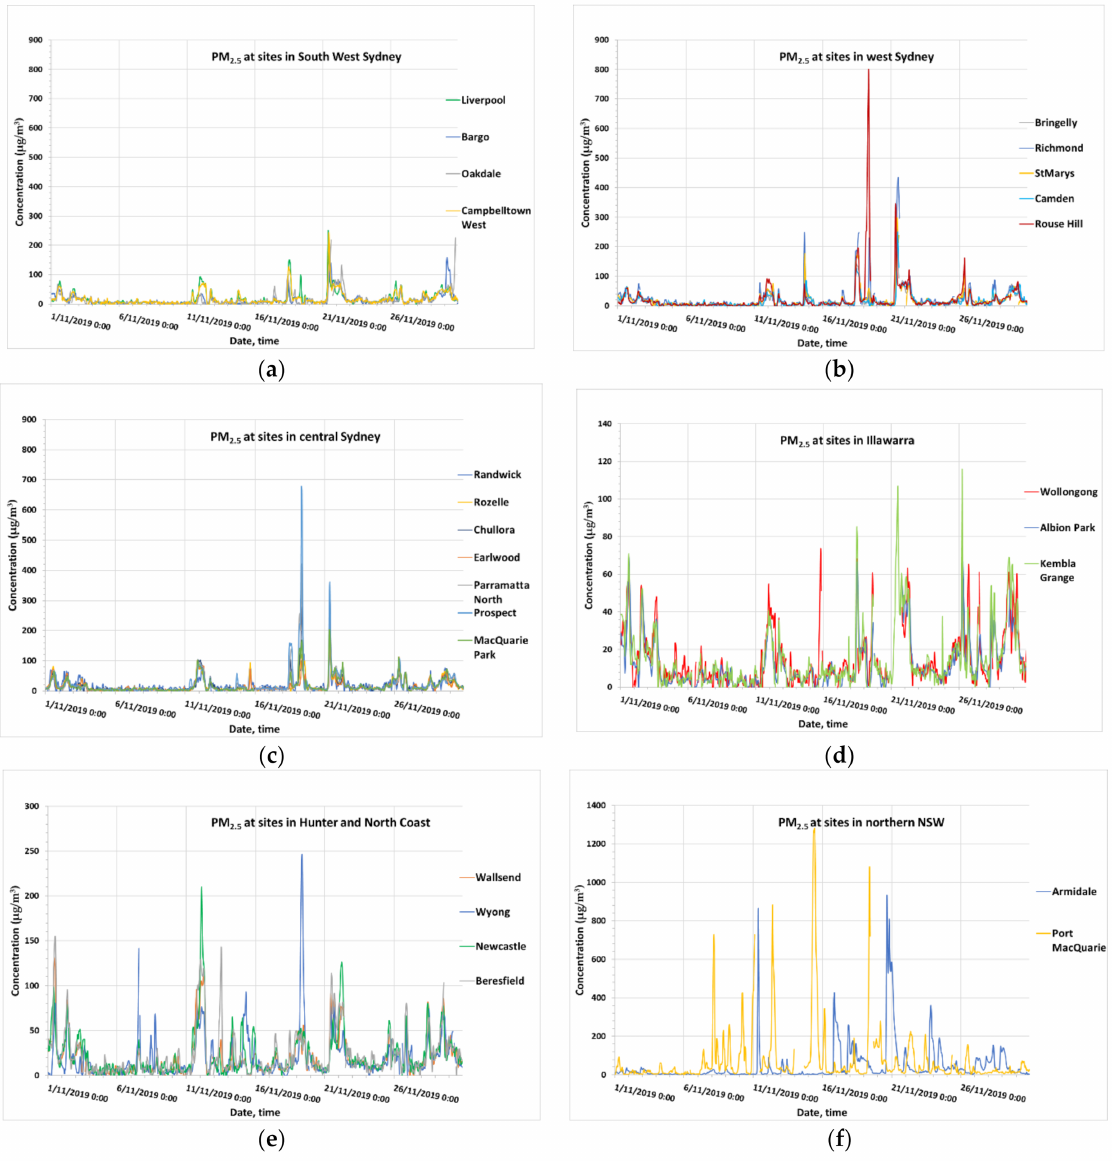
Figure 7. PM 2.5 concentration at monitoring sites in South West Sydney ( a ), west Sydney ( b ), central Sydney ( c ), Illawarra ( d ), Hunter ( e ) and northern NSW ( f ) from 1 November 2019 to 30 November 2019. From early December, the fires caused an elevated concentration of PM 2.5 up to 273.7 µ g/m 3 (6 December 2019, 08:00) as measured at Port Macquarie. High PM 2.5 concen- trations from 200 µ g/m 3 up to above 400 µ g/m 3 were measured at a number of stations in Sydney (Bringelly, Camden, Liverpool, Oakdale, Campbelltown West, Rozelle, Randwick, Parramatta North, Chullora, Earlwood, Macquarie Park and Prospect) and in the Lower Hunter–Central Coast region (Wallsend, Newcastle, Beresfield and Wyong) from 3